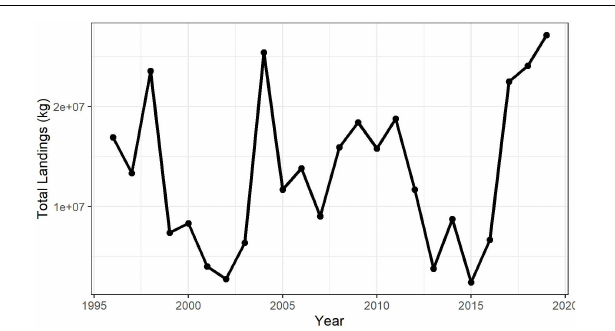
FIGURE 3 | Shortfin squid landings in the US fishery from 1996 to